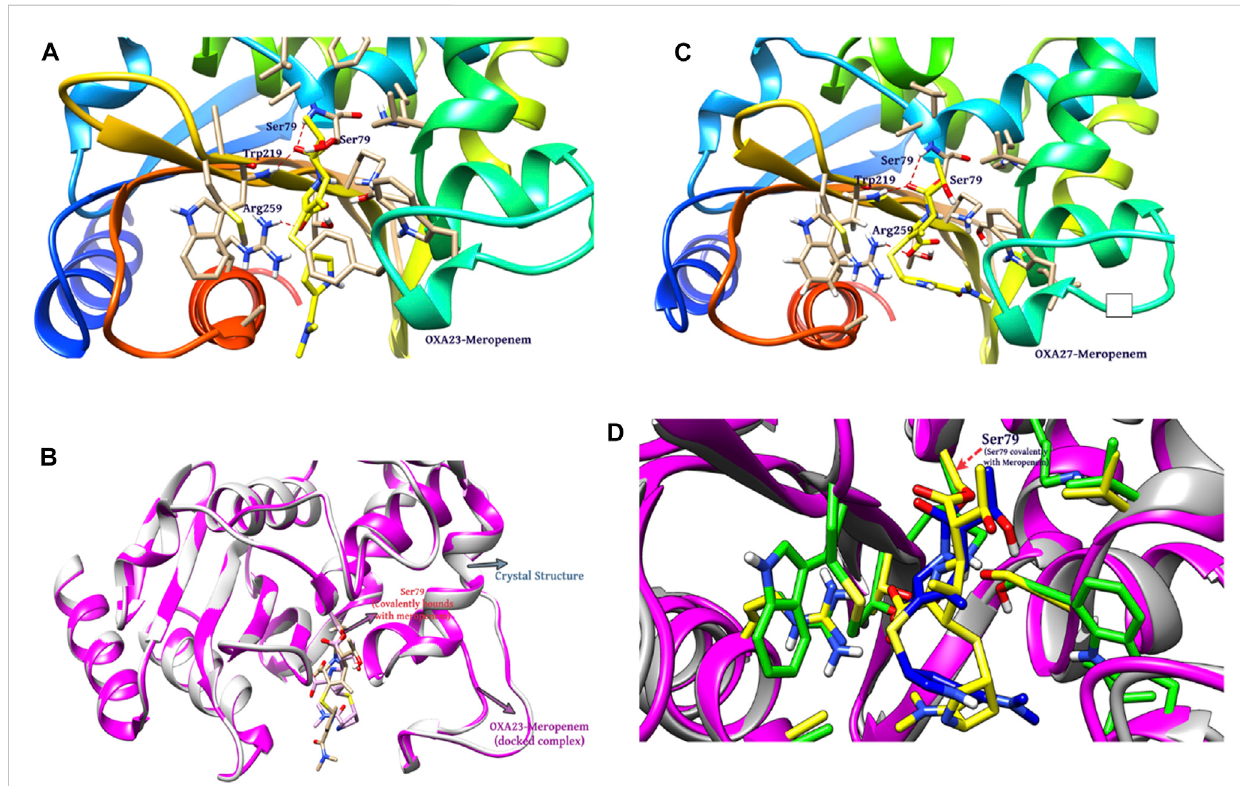
FIGURE 2 Interaction of meropenem with (A) OXA-23. (B) Superimposition of OXA-23 (docked complex, pink color) and the crystal structure (gray color) (results: 0.2 Å). (C) OXA-27. (D) Superimposition of OXA-23 (pink color) and OXA-27 (gray color) (results: 0.5